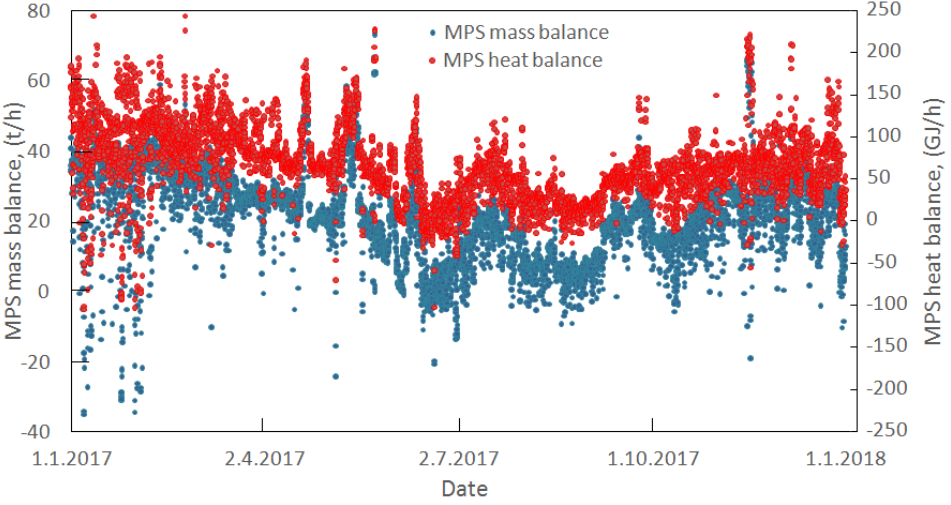
Figure 7. A difference between the amount of steam supplied and consumed within the MPS network during the year 2017.